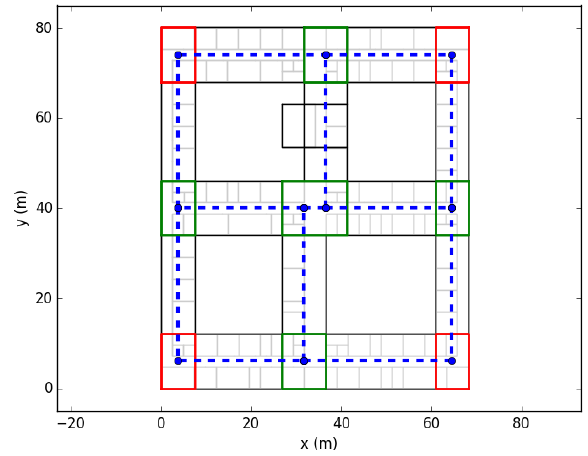
Figure 3. External shell center line (blue dashed), corner (red) and branch (green)